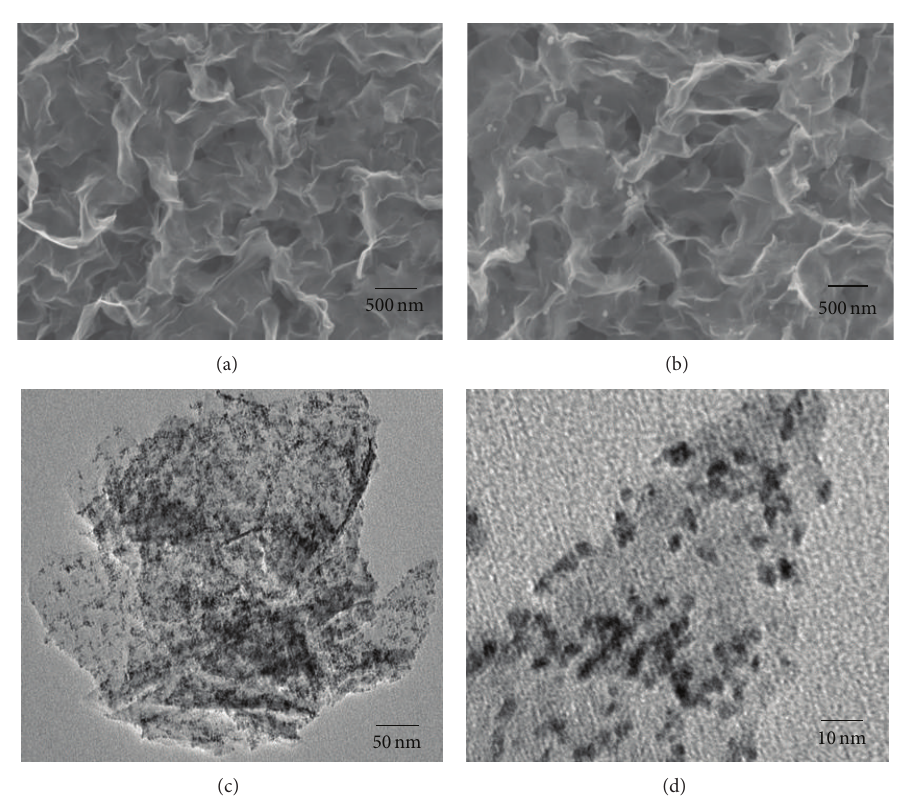
Figure 2: SEM images of TiO 2 and Pt-TiO 2 nanosheet